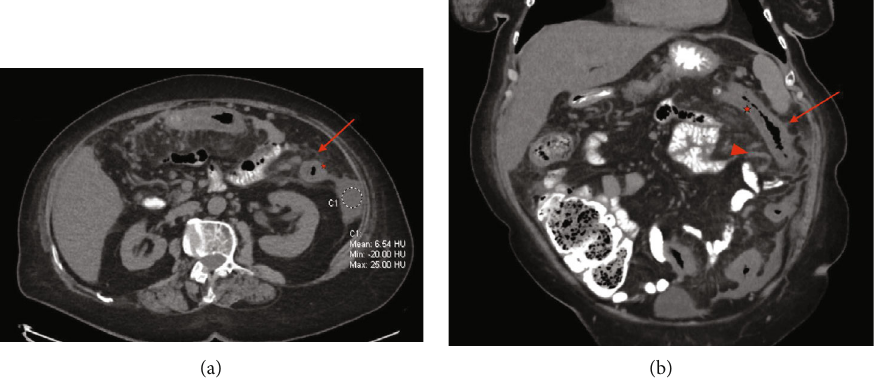
Figure 1: Initial presentation to the emergency department with di ff use abdominal pain and diarrhea. CT abdomen and pelvis with oral contrast only. Axial image (a) displays colonic mural thickening (star) and adjacent pericolonic fat stranding (arrow) most pronounced in the descending colon with ascites in the left paracolic gutter (circled). Coronal image (b) displays left hemicolon mural thickening (star) and adjacent pericolonic fat stranding (arrow) in the region of the IMA distribution. Suggestion of a prominent vascular structure is noted medial to the descending colon